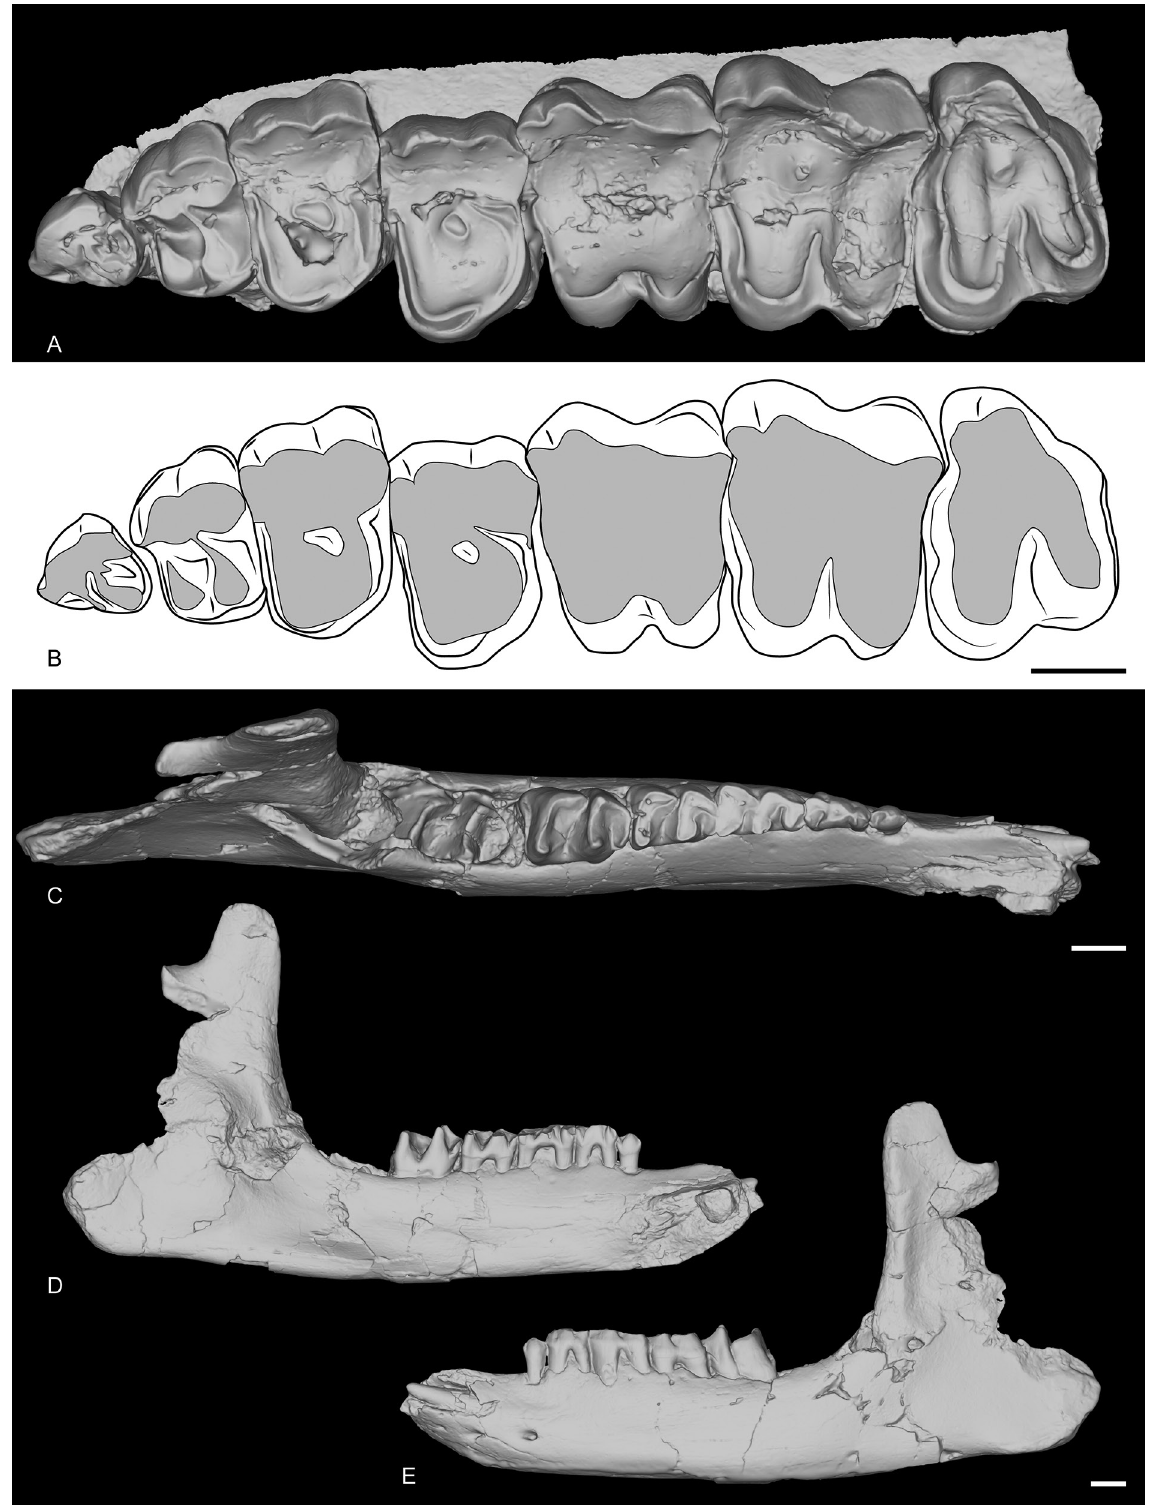
Fig. 16. Ronzotherium romani Kretzoi, 1940 from Poillat, near Delémont (late early Oligocene, Switzerland). – A–B . Left maxilla MJSN-POI-007-3219 with P1–M3. A . Occlusal view. B . Drawing of P1–M3. – C–E . Right juvenile hemimandible MJSN-POI-007-174 with erupting i2, d1–4, m1 and erupting m2. C . Occlusal view. D . Medial view. E . Lateral view. Scale bars: 2